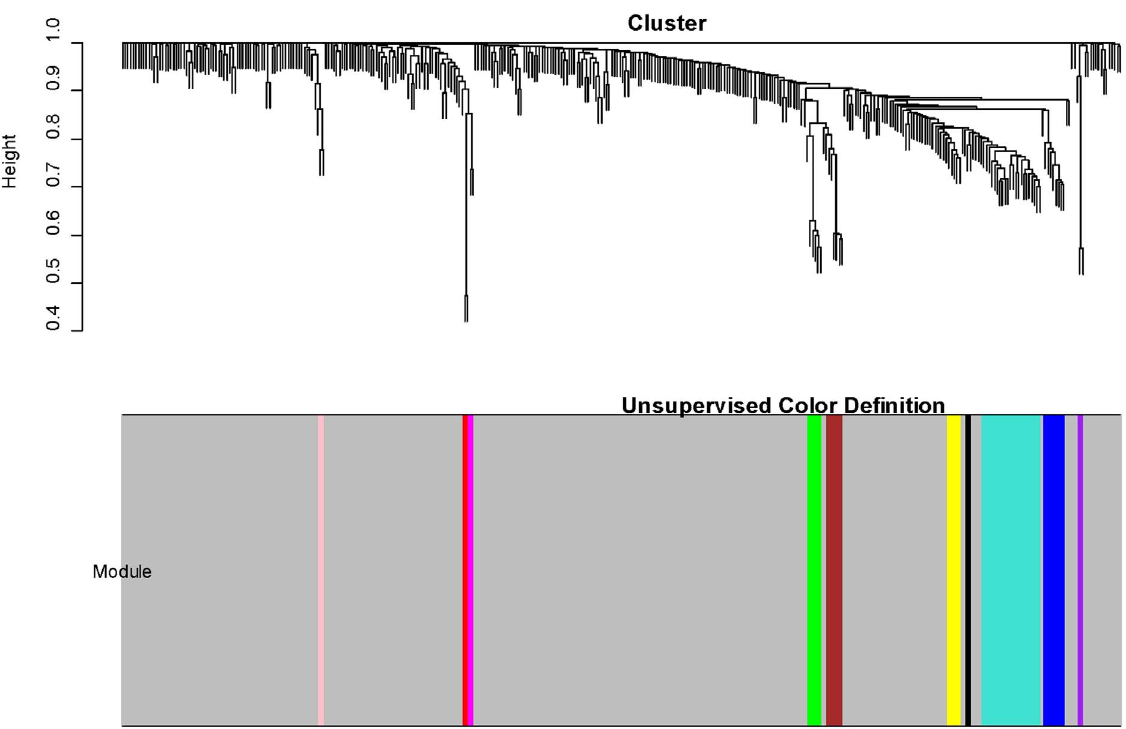
Figure 4. The visualization of the coexpression network for DMET genes. The graph highlights that genes in a liver coexpression network fall into 10 distinct modules, where genes within a module are more highly interconnected with each other than with genes outside the module.